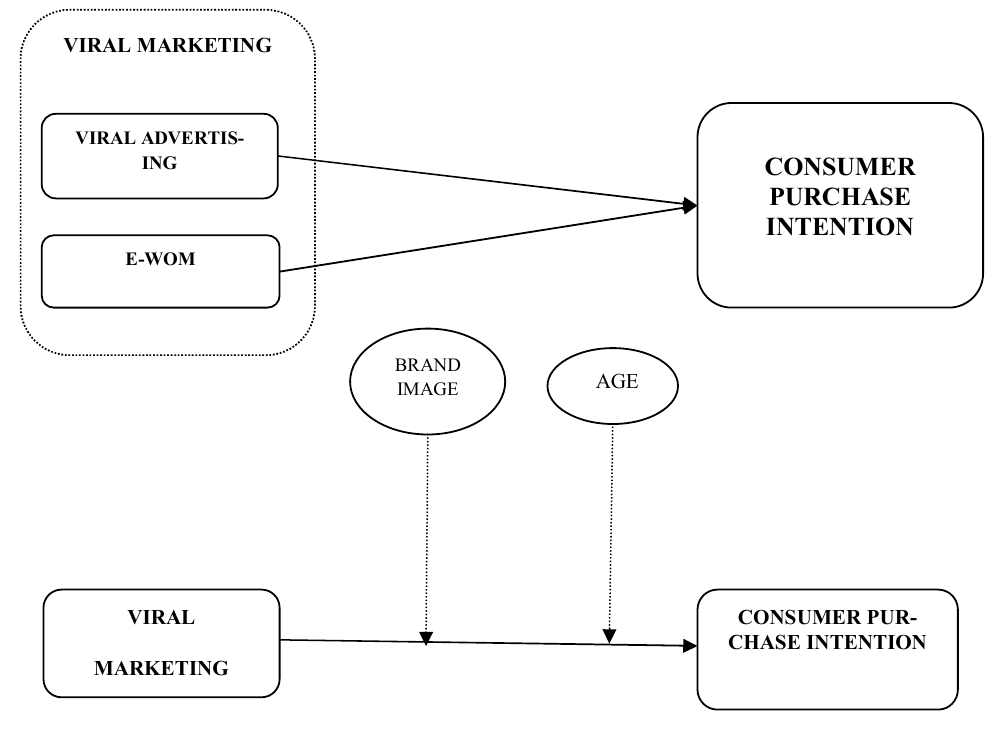
Fig. 1. the conceptual model of the